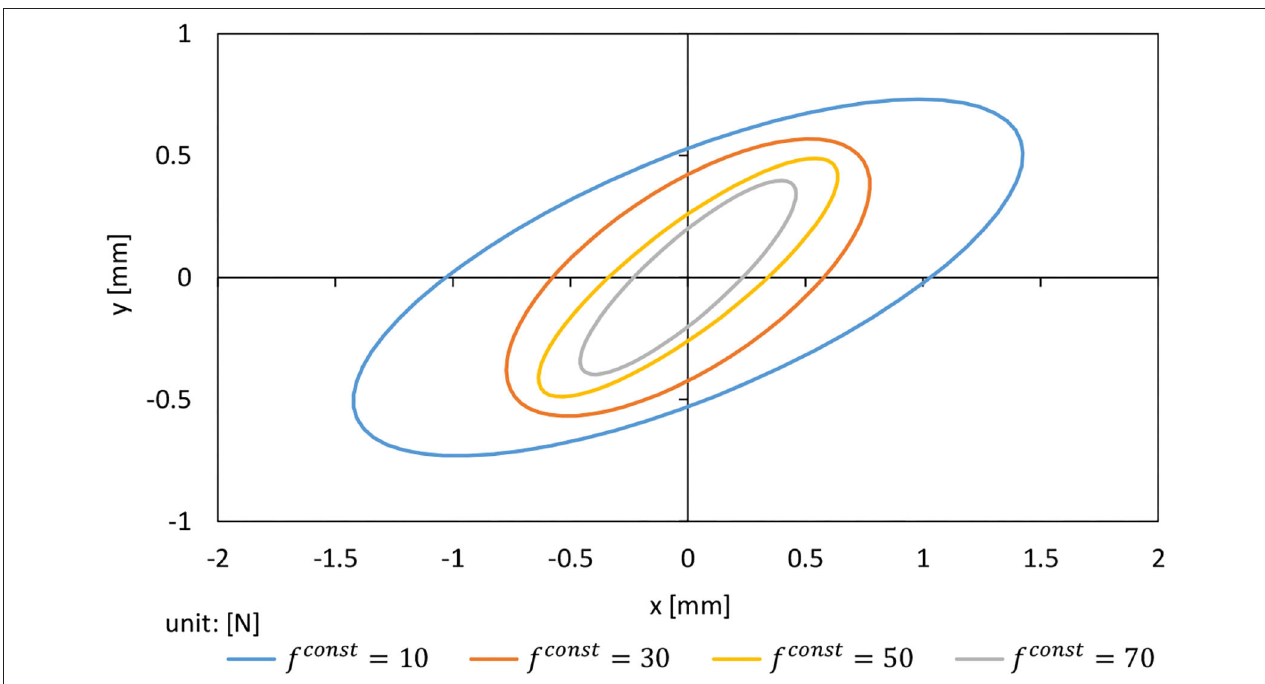
FIGURE 3 | Operational stiffness ellipsoid when adding force of 1 N while changing f const = { 10,30,50,70 } [N]. angle θ , muscle tension f , and muscle length l (Kawaharazuka et al.,